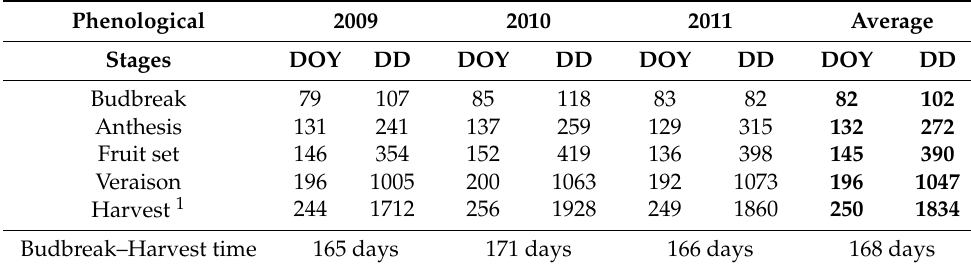
Table 2. Phenological stages in day of the year (DOY), degree days (DD), and period duration from budbreak to harvest in the years 2009, 2010, and